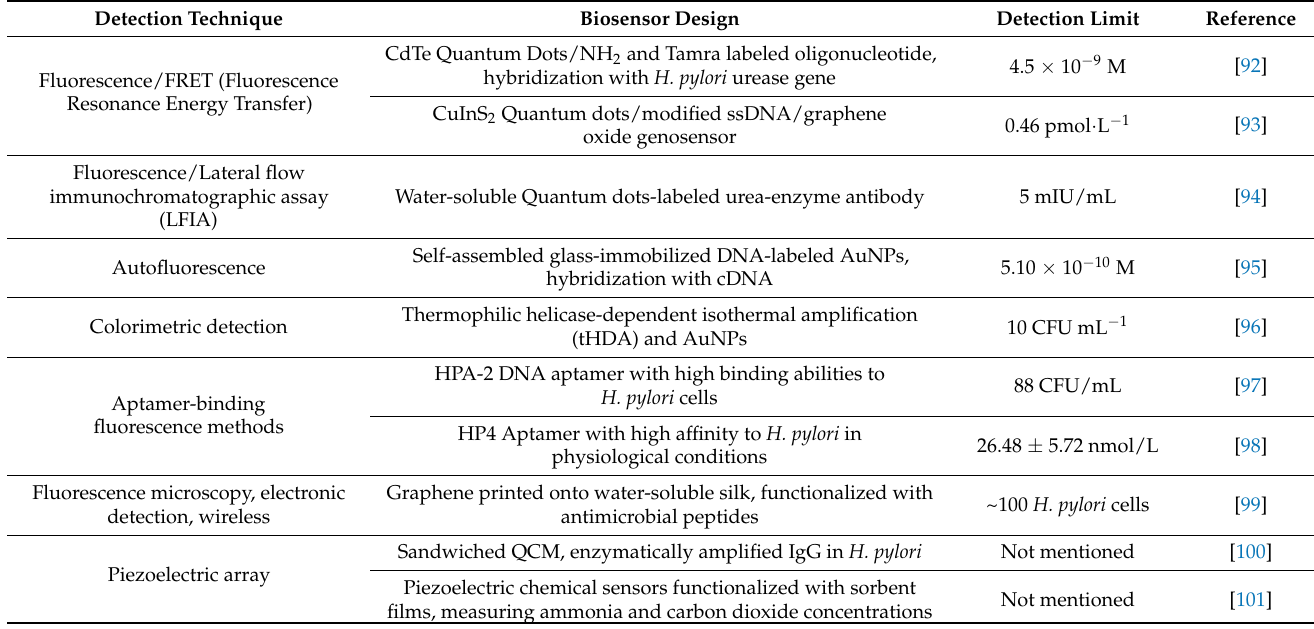
Table 2. Nano-biosensors for rapid detection of H. pylori